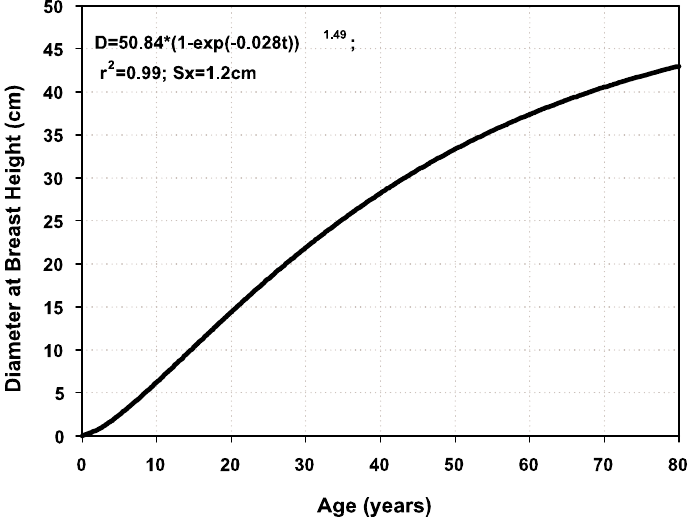
Figure 8. Diameter growth curve for pines (source: 41) (Note: r 2 = coefficient of determination, Sx = Standard error, P =